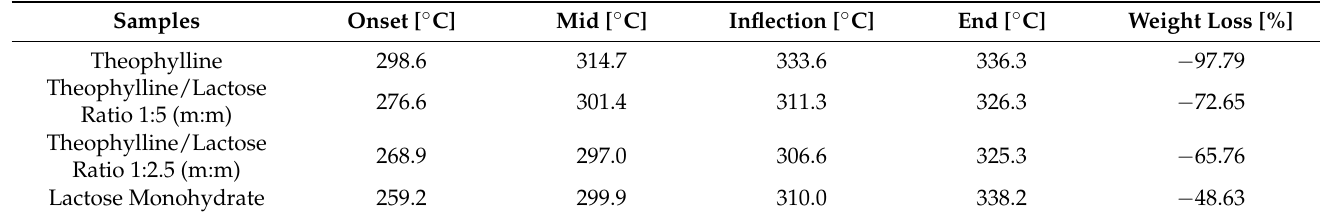
Table 4. Characteristic parameters of TGA, and D2TG curves of the tested samples.